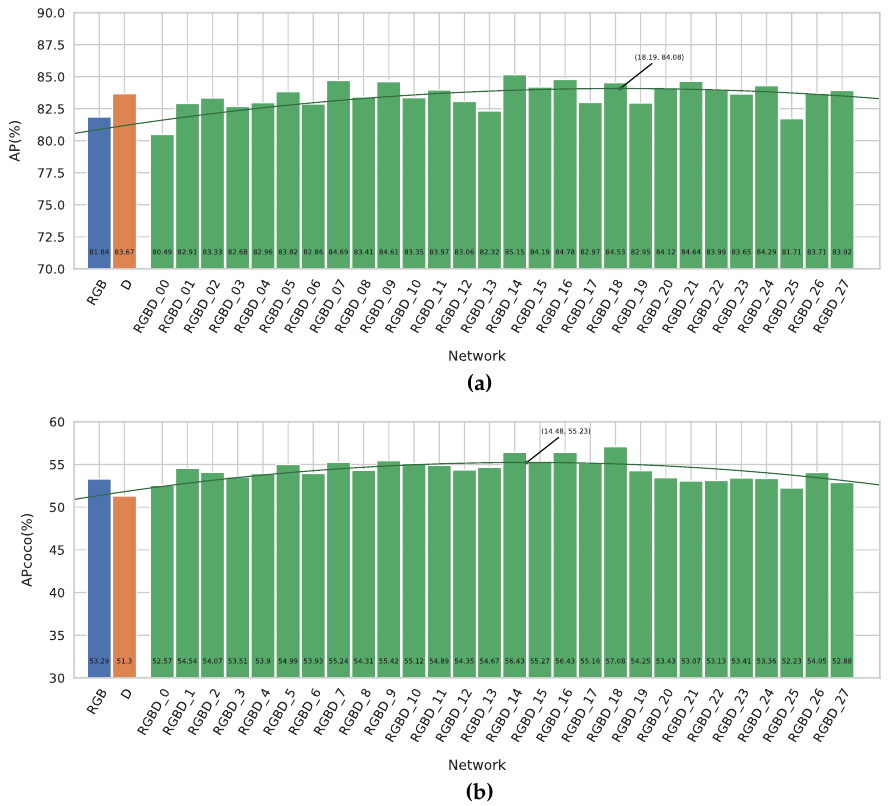
Figure 4. The results of our different networks on the Relabeled EPFL Pedestrian Dataset. ( a ) The regular AP metric of our different networks. ( b ) The AP COCO metric of our different